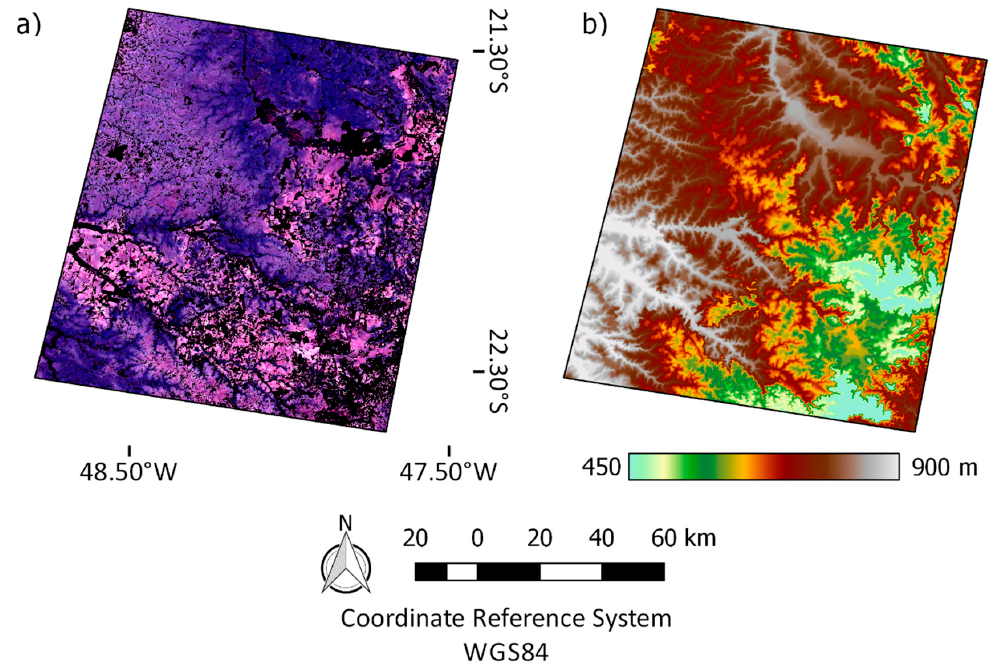
Table 2. Descriptive statistics of the environmental covariates used for clay and sand mapping. Covariate Description Band no. 7 from the SYSI [33] with the Landsat 5 TM spectral range 2080–2350 nm Elevation from the digital elevation model of Shuttle Radar Topography Mission (1 arc second ~30 m) with vertical inaccuracy <16 m Channel network base level calculated from SAGA GIS version 2.1.2 [44] Relative slope calculated from SAGA GIS version 2.1.2